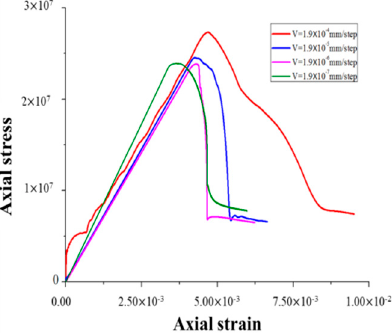
Figure 10. Stress–strain curves for different loading rates.